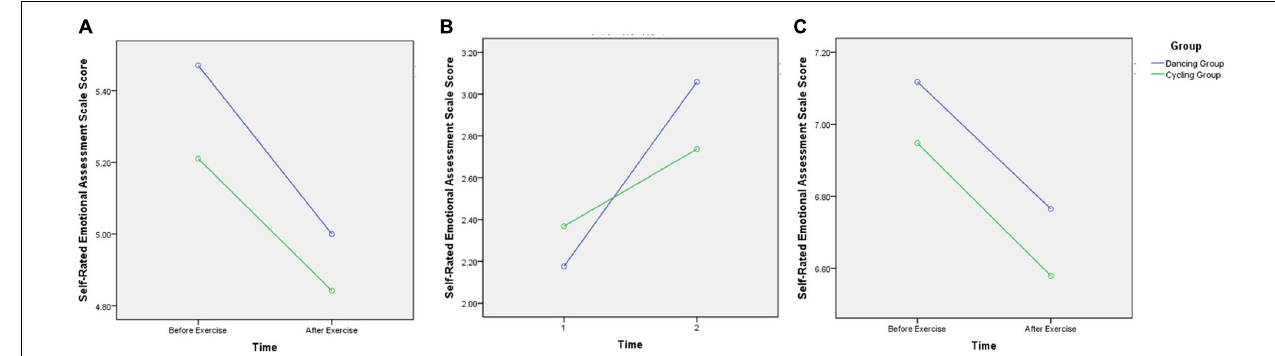
FIGURE 3 | Comparison of self-rated emotional scale score for viewing different valence images before and after exercise intervention in the two groups. (A) The self-rated emotional scale score for viewing neural images before and after exercise intervention in the two groups; (B) The self-rated emotional scale score for viewing negative images before and after exercise intervention in the two groups; (C) The self-rated emotional scale score for viewing positive images before and after exercise intervention in the two groups. Though there was no interaction effect of time and group ( F 2 , 33 = 0.19; p = 0.67), we found a trend increase in the self-rated emotional scale score for viewing negative images in both groups after 30-min exercise intervention, and the dancing group presented more significant trends than cycling group.